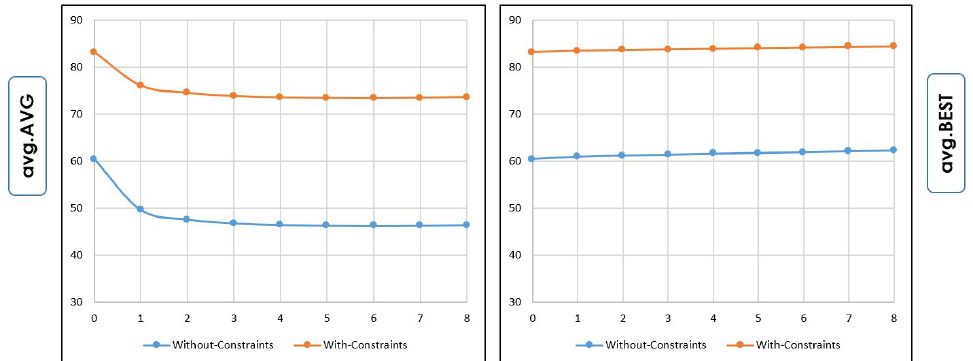
Figure 29. Evaluation of two score functions over the iterations (with and without constraints). Both scenarios (with/without constraints) follow the same pattern, and the proposed approach generates better plans comparable to those generated without